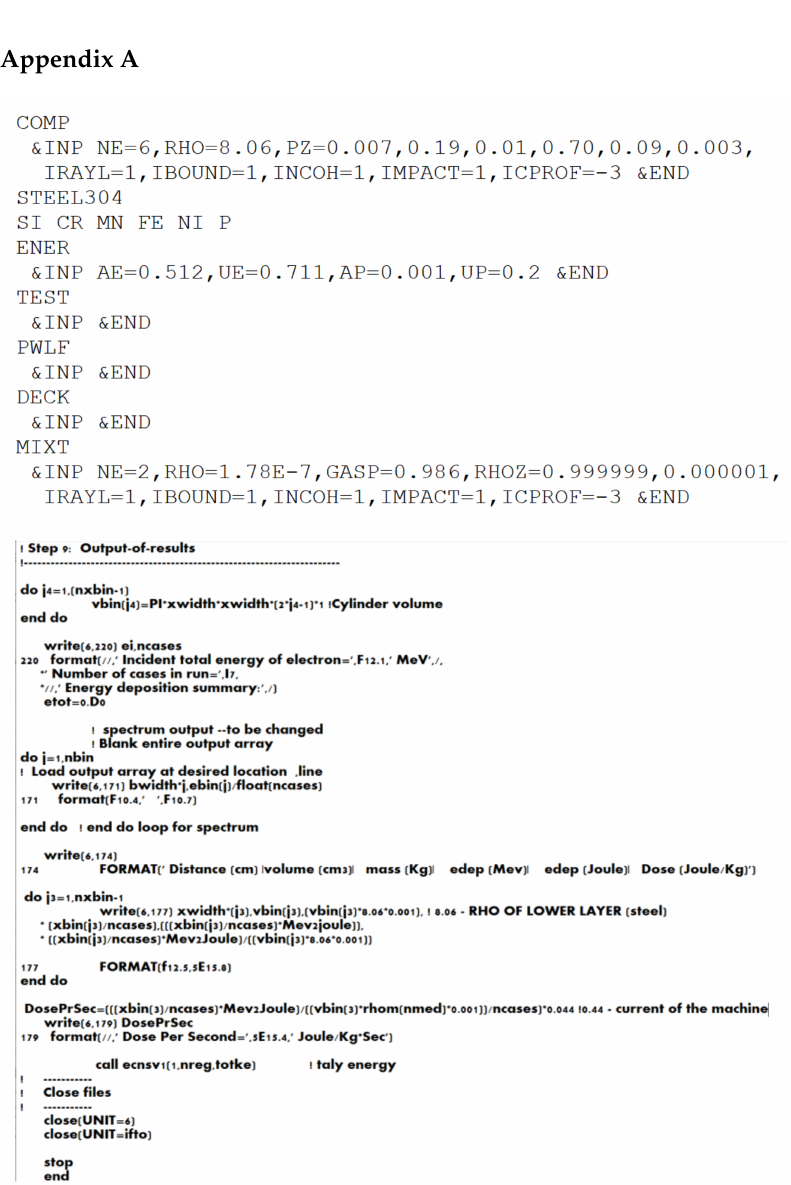
Figure A1. Part of EGS5 main user code and materials file.